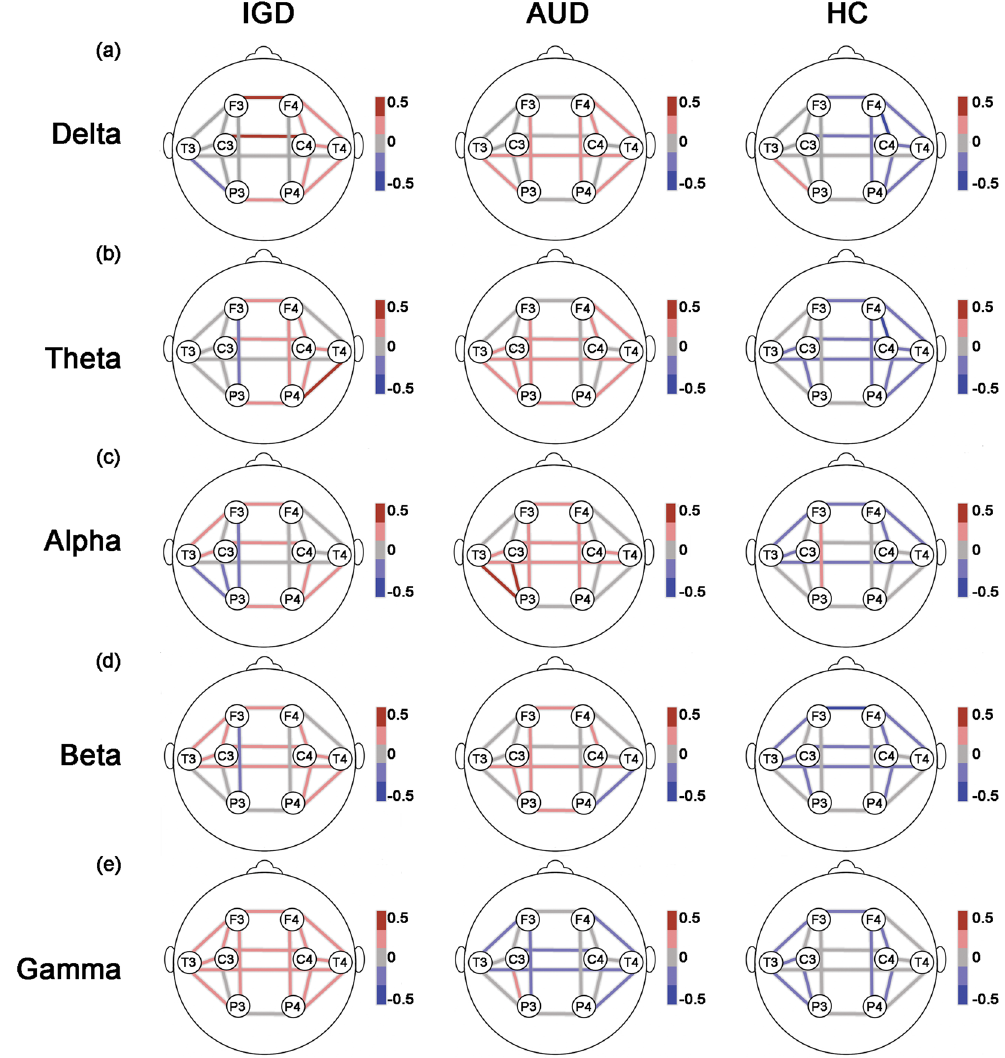
Figure 1. Coherence without controlling effects of psychological covariates. The lines represent estimated coherence means of the groups by GEE at each location for the ( a ) delta, ( b ) theta, ( c ) alpha, ( d ) beta, and ( e ) gamma bands. The effects of demographic data (age, education, and IQ) were controlled; however, that of psychological data (scores on the BDI-II, BAI, and BIS-11) were not controlled in analyses. The meaning of bar scales ranging from − 0.5 (blue) to 0.5 (red). Fisher’s Z-transformed scores were used for the EEG data. IGD = Internet gaming disorder; AUD = alcohol use disorder; HC = healthy control; GEE = generalized estimating model; EEG = electroencephalography; IQ = intelligence quotient; BDI-II = Beck Depression Inventory-II; BAI = Beck Anxiety Inventory; and BIS-11 = Barratt Impulsivity